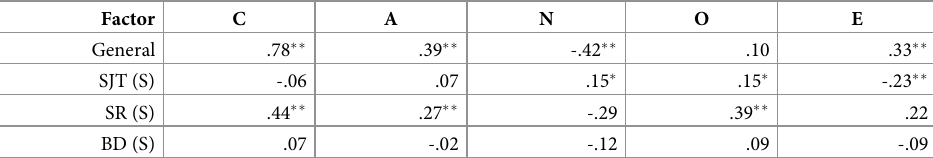
Table 2. Bi-factor model correlations with the bfi personality